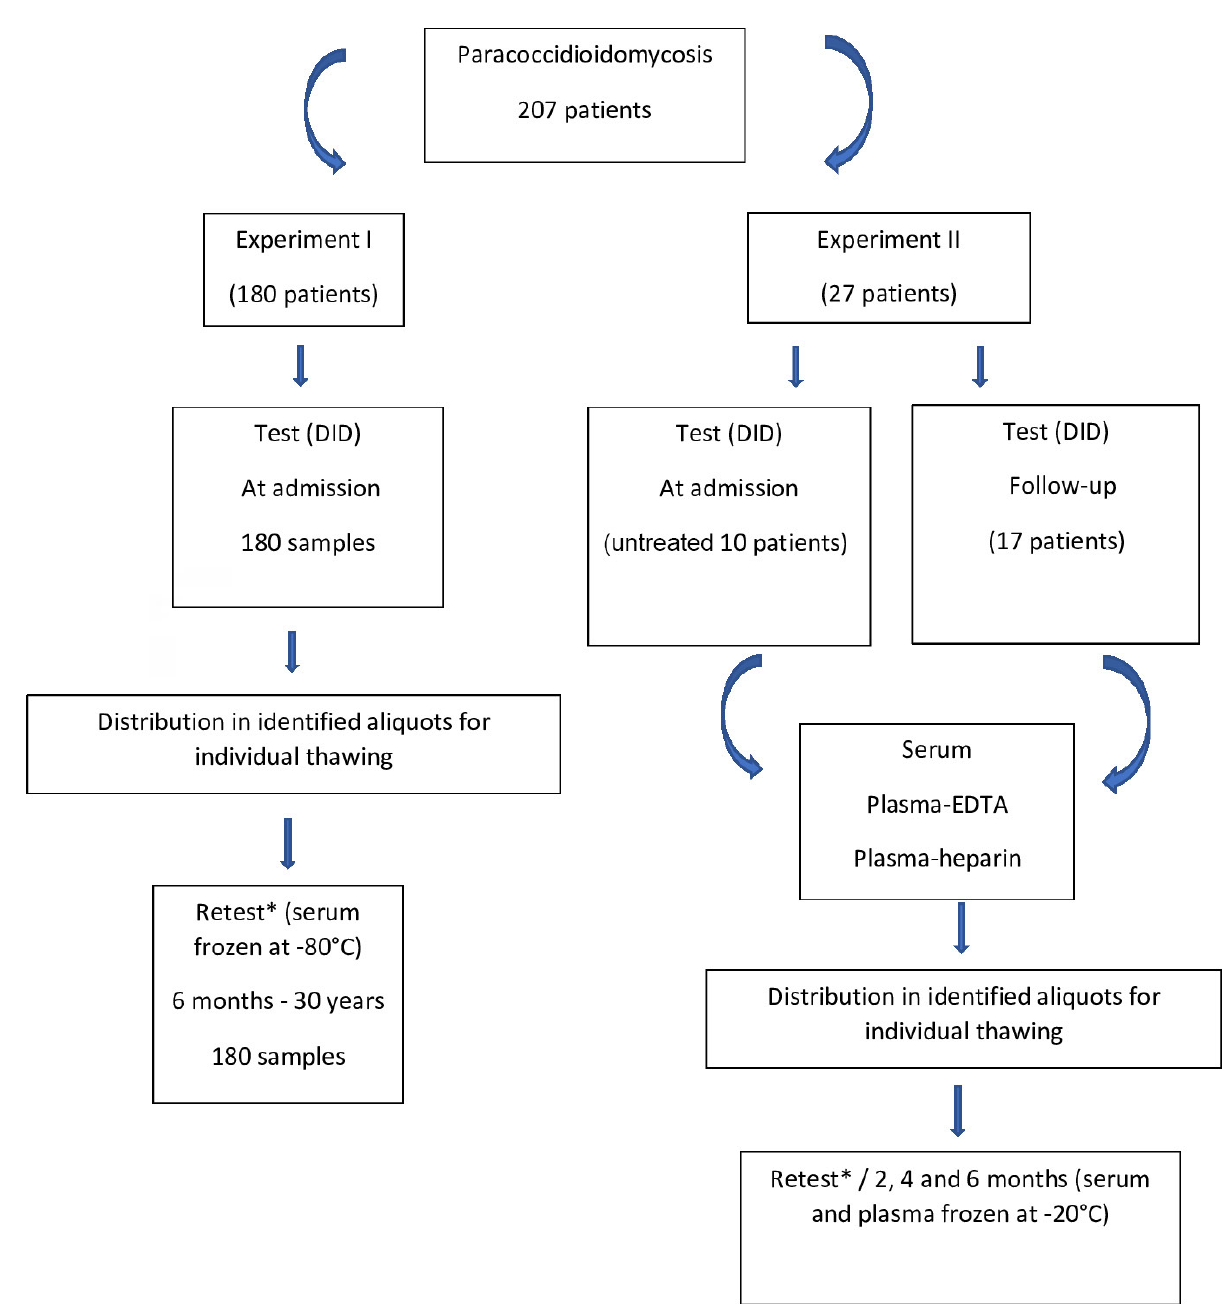
Figure 1. Study design to evaluate the anti- Paracoccidioides brasiliensis circulating antibodies determined by the double agar gel immunodiffusion test in serum and plasma obtained with ethylenodiaminetetracetic acid (EDTA) or heparin. Influence of freezing on different blood matrices, stored in aliquots to be thawed only once, on the titration of the antibodies. *The retest was performed in the same sample used in the